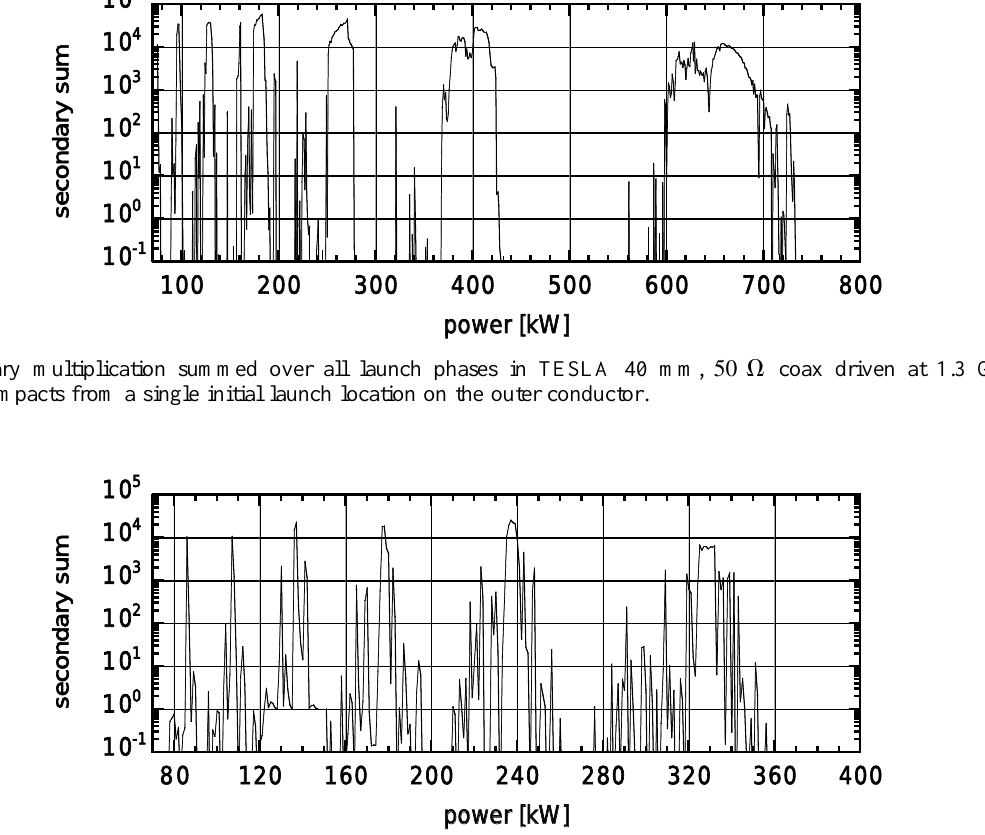
FIG. 2. Secondary multiplication summed over all launch phases in CESR 10.2 cm 3 43.1 cm rectangular waveguide driven at 500 MHz with a maximum of 20 impacts from a single initial launch location on the midline.